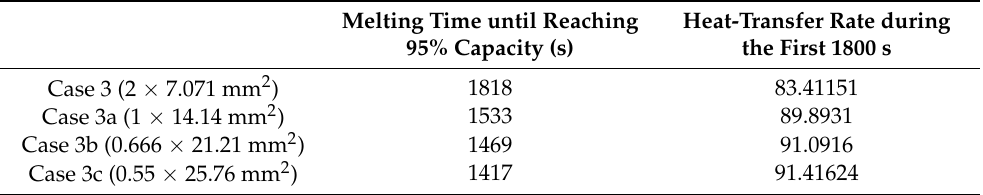
Figure 14. The average temperature profiles for the total PCM for the cases (case 3 (size 1: 2 × 7.071 mm 2 ), case 3a (size 2: 1 × 14.14 mm 2 ), case 3b (size 3: 0.666 × 21.21 mm 2 ), and case 3c (size 4: 0.55 × 25.76 mm 2 )). Table 2. Melting time until achieving 95% and the heat-transfer rate in 1800 s for the cases of case 3 (2 × 7.071 mm 2 ), case 3a (1 × 14.14 mm 2 ), case 3b (0.666 × 21.21 mm 2 ), and case 3c (0.55 × 25.76 mm 2 ).